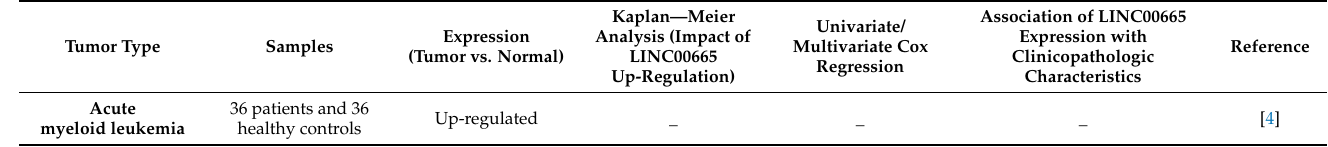
Table 3. Dysregulation of LINC00665 in clinical samples (ANCTs: adjacent non-cancerous tissues,